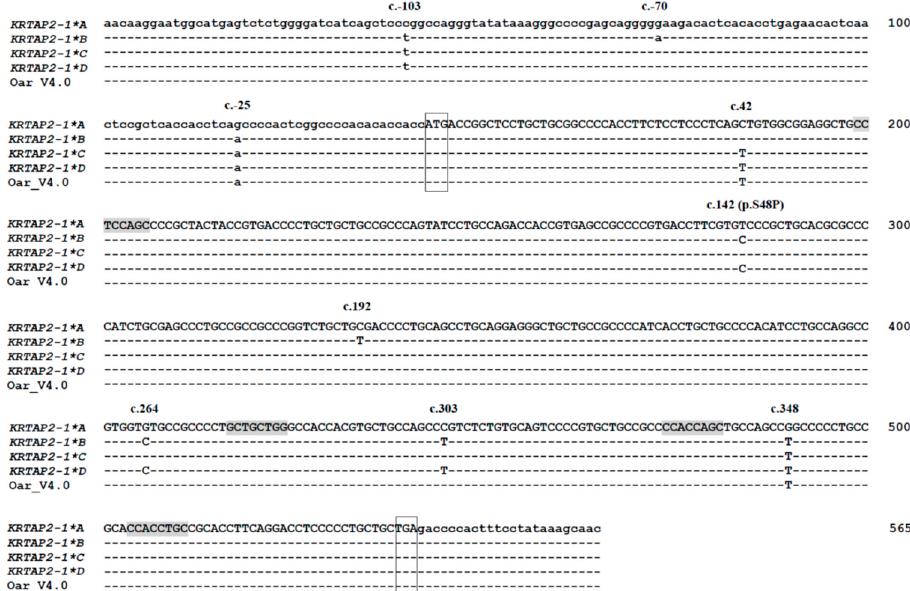
Figure 4. Alignment of the ovine keratin-associated protein 2-1 gene variant sequences ( A – D ), together with the Ovine Genome Assembly version 4.0. The abbreviation KRTAP2-1 stands for keratin associated proteingene2-1. Nucleotidesoutsidethecodingregionareshowninlowercase, whilethoseinthecoding region are in uppercase. The predicted ATG start codon and TGA stop codon are marked with boxes. The positions of single nucleotide variations are shown above the sequences, and the non-synonymous substitution (p.S48P) is indicated. Dashes represent nucleotides identical to the top sequences. Chi and chi-like sequences are shaded. The nucleotide and amino acids are numbered according to the guidelines of the Human Genome Variation Society (HGVS) nomenclature, with, for example, c.-25 being the nucleotide position 25 base pairs upstream of the ATG start